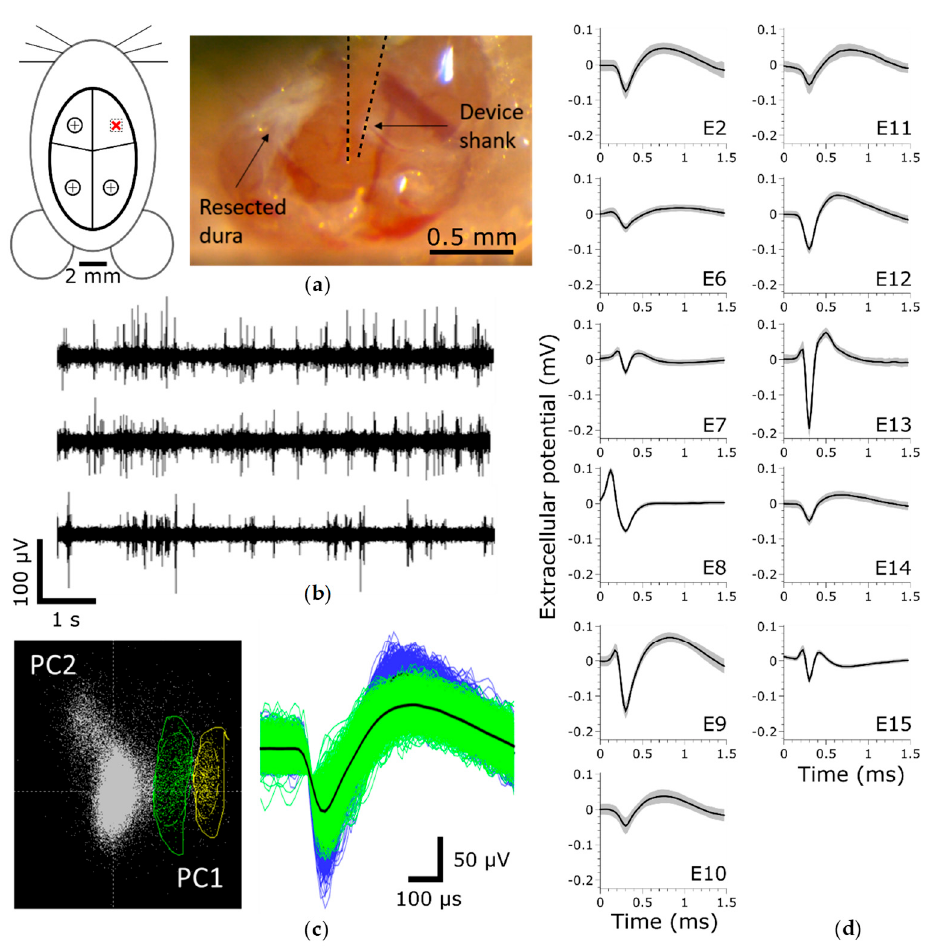
Figure 2. Neural data acquisition and waveform analysis. ( a ) Implantation schematic denoting the implantation site (red “x”) and stabilizing screws, ( b ) filtered continuous data from three representative electrodes on a single array, ( c ) representation of single-unit sorting principals (left) and representative multi-unit activity from a single recording electrode (right), ( d ) single units recorded on a single array during a single recording session, ordered from array tip (E2) to base (E15).